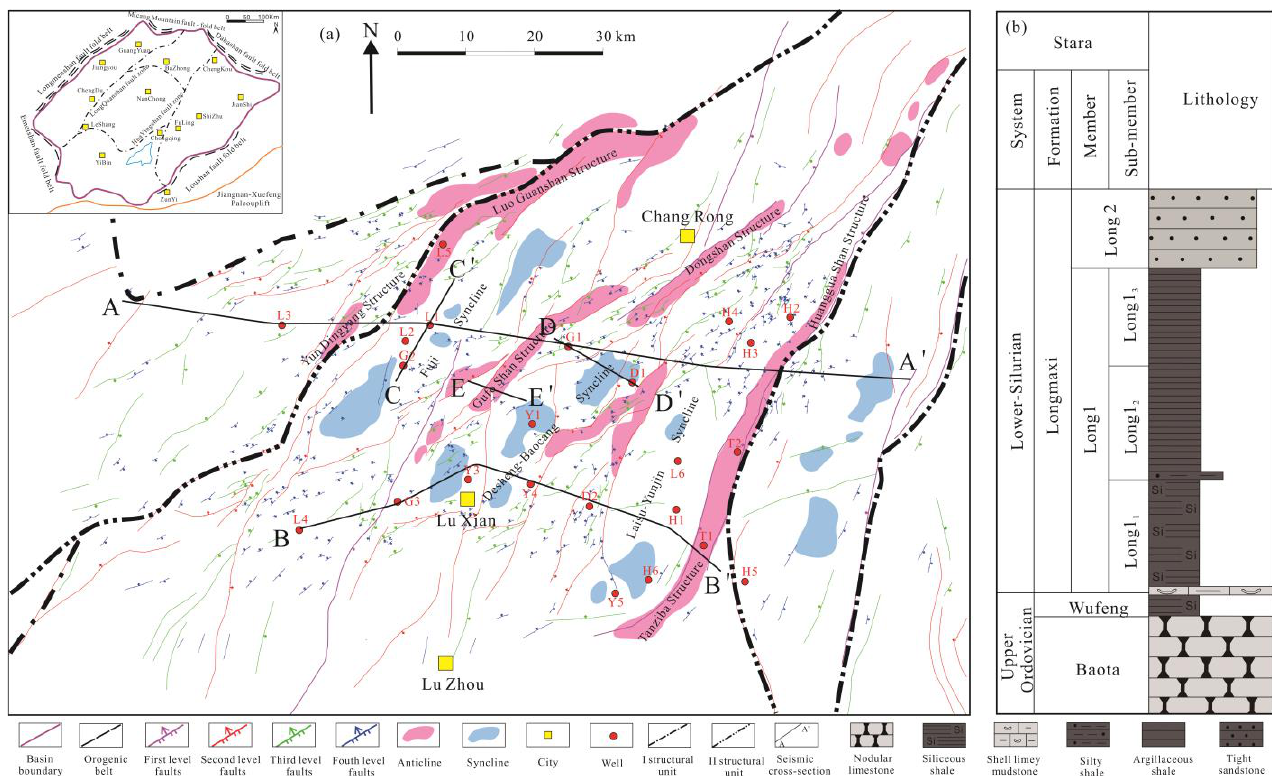
Figure 1. The regional tectonic positioning. ( a ) The regional geology of the Luzhou area; ( b ) a regional stratigraphic comprehensive histogram.